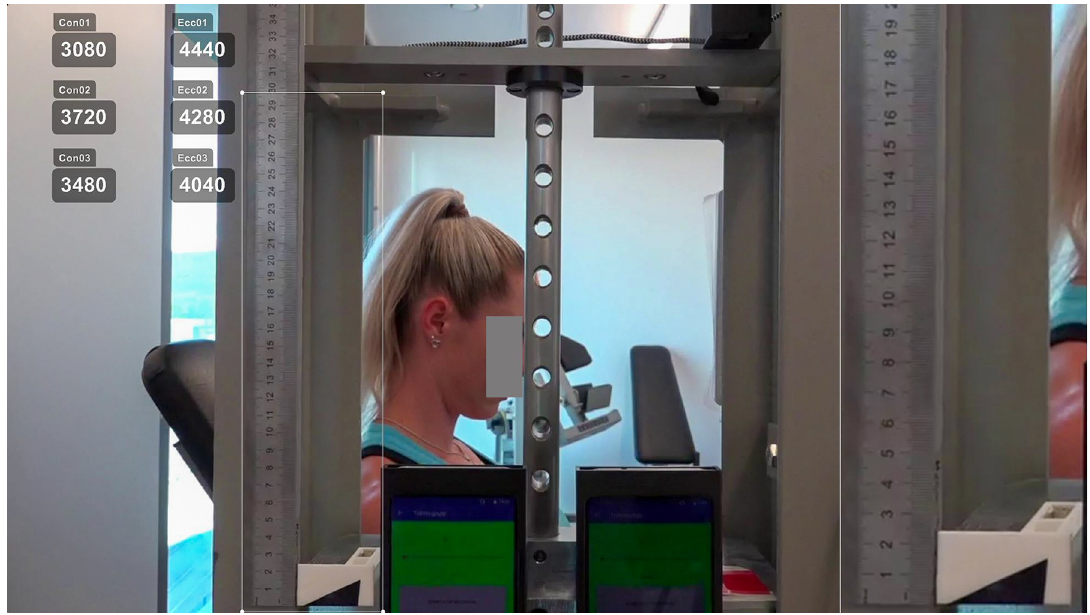
Fig 2. Rating of video recordings. Time per contraction phase was annotated in milliseconds using a 2.5x magnification of the weight